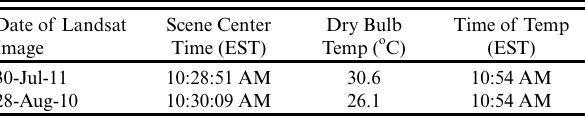
Table 4 . The date of the Landsat images, their scene center time (EST), the corresponding dry bulb temperature (oC), and time of the temperature measurement (EST).